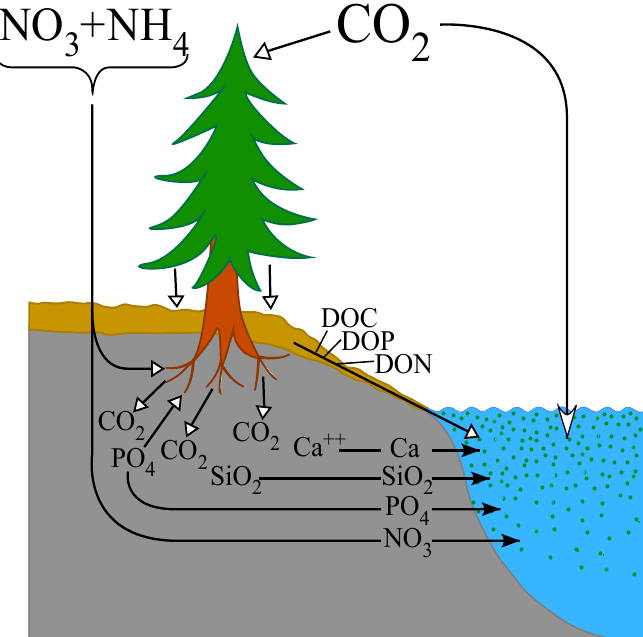
Figure 1. Conceptual and simplified relationships and feedbacks between dissolved inorganic nitrogen (DIN)-deposition in catchments, catchment processes including root weathering, uptake and release of elements relevant for aquatic productivity. This again feed into the C-dynamics via aquatic uptake or release of CO further